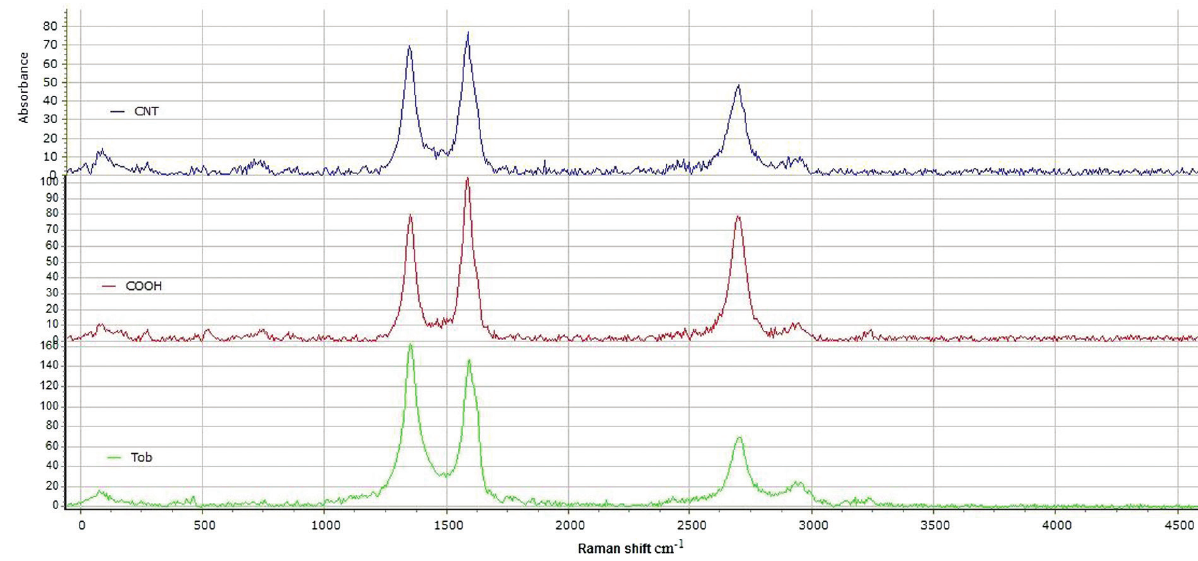
Figure 2: Raman spectra of the raw CNT, carboxylated CNT and tobacco-functionalized